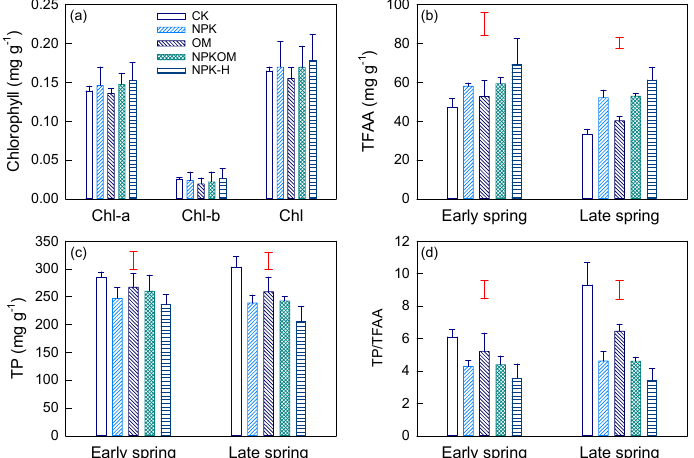
Figure 4. Concentrations of chlorophyll (chl-a, chl-b, and total) ( a ), total free amino acid (TFAA, b ), total polyphenol (TP, c ) and their ratio (PP/TFAA) ( d ) in young shoots in the early and late spring. Single bars in red without data above columns are LSD values indicative of significant difference among fertilization treatments.